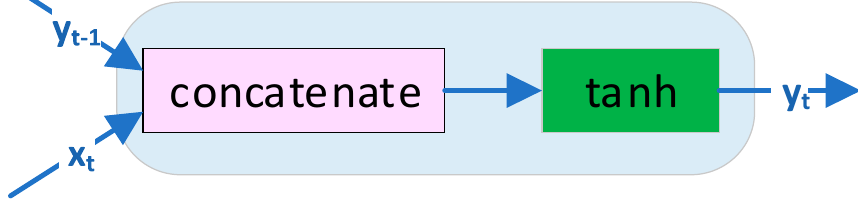
Figure 1. Standard recurrent unit.